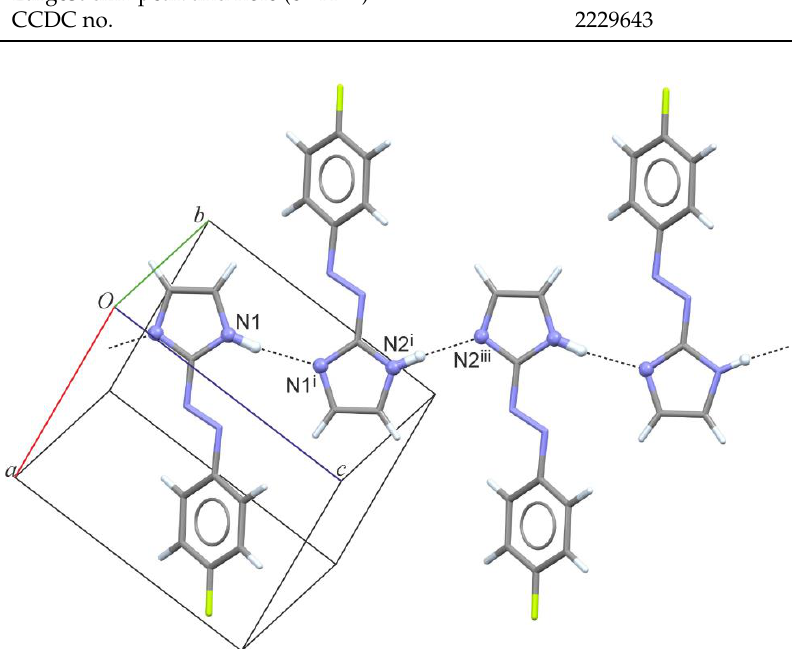
Figure 2. H-bonded chain structure displaying an ordered sequence of alternating locations for the NH group at either N1 or N2. Symmetry codes: (i) ‒x, ‒y + 1, ‒z + 1; (iii) x ‒ 1, y, z + 1.